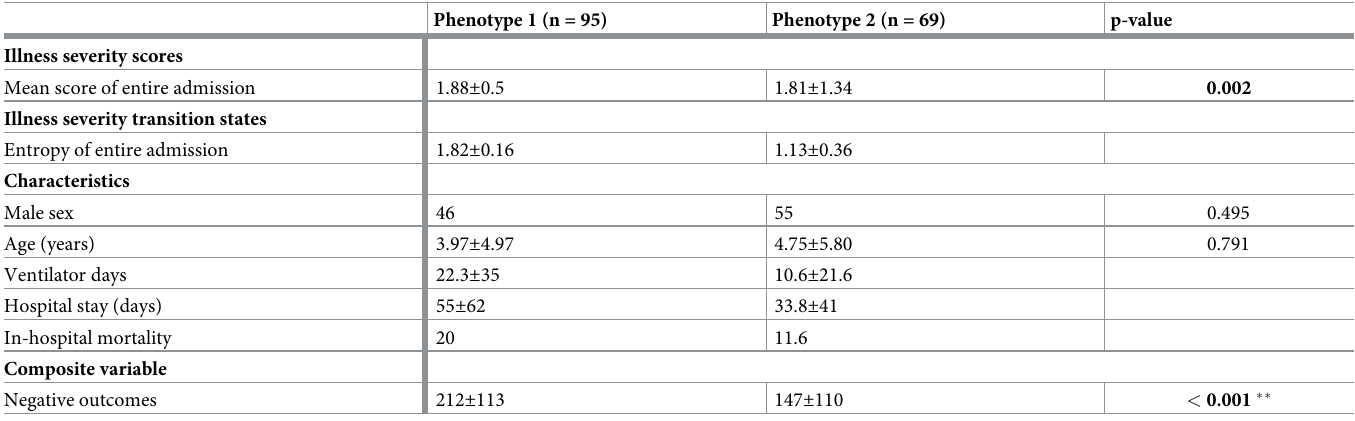
Table 2. Characteristics of dynamic phenotypes: Two